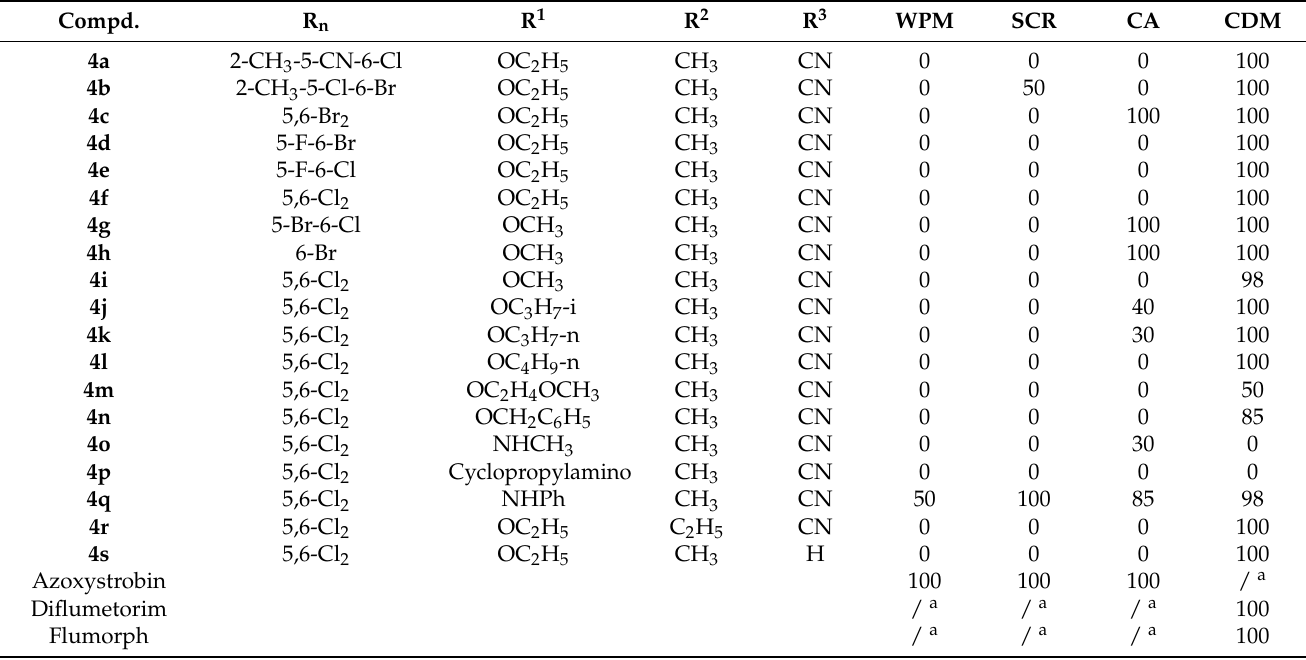
Table 1. The in vivo fungicidal activities of target compounds 4a ~ 4s in green house at 400 mg/L. Compd.